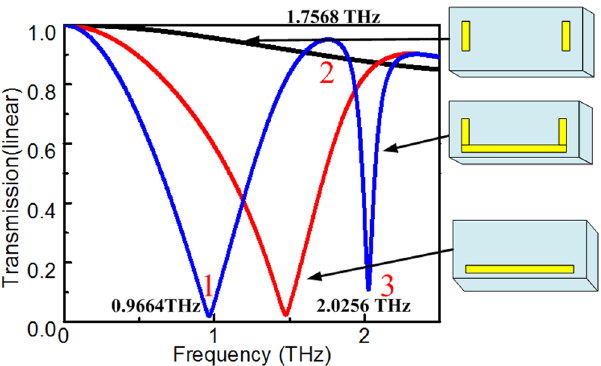
Figure 2. Transmission spectra for a = 100 μ m, b = 38 μ m, d 1 = 0.02 μ m, d 2 = 12 μ m, l 1 = 80 μ m, w = 4 μ m,